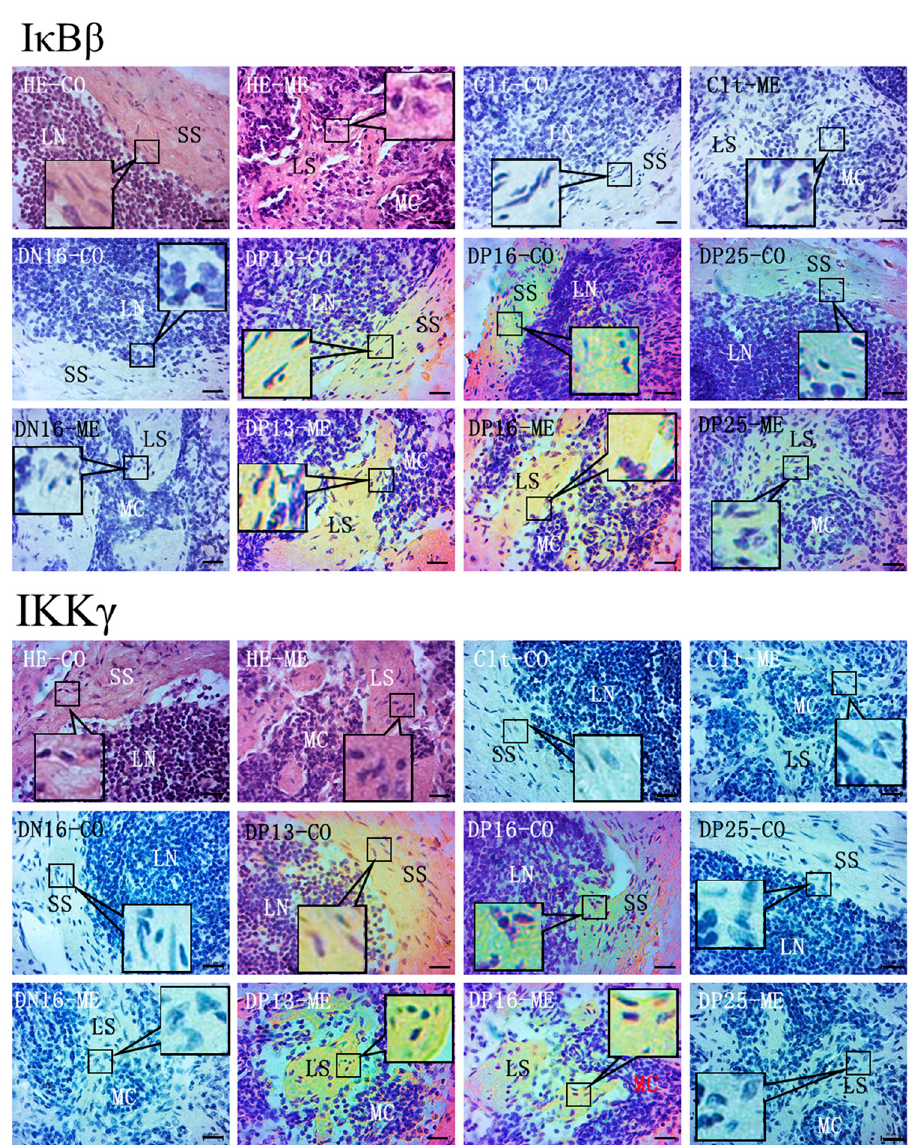
Figure 6. Representative immunohistochemical localization of I κ B β and IKK γ proteins in the lymph nodes from non-pregnant ewes and pregnant ewes. The lymph node is divided into the outer cortex (CO) and the inner medulla (ME). Lymph enters the convex through the subcapsular sinus (SS) around the lymphoid nodules (LN), and flows into the medulla through the lymph sinus (LS) around the medullary cord (MC). Note: HE = stained by hematoxylin and eosin; Clt = negative control; DN16 = day 16 of the estrous cycle; DP13 = day 13 of pregnancy; DP16 = day 16 of pregnancy; DP25 = day 25 of pregnancy. Bar = 20 µm.